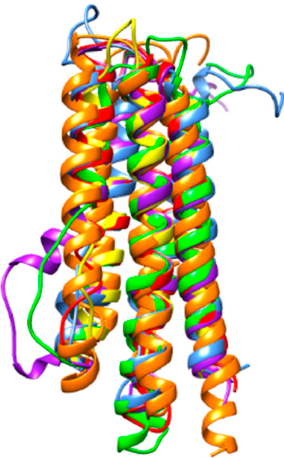
Figure 9. Superposition of the ribbon diagrams of apolipophorin III from Acheta domesticus (blue), Bombyx mori (green), Locusta migratoria (red), Galleria mellonella (purple), Schistocerca gregaria (yellow), and Tenebrio molitor (orange).